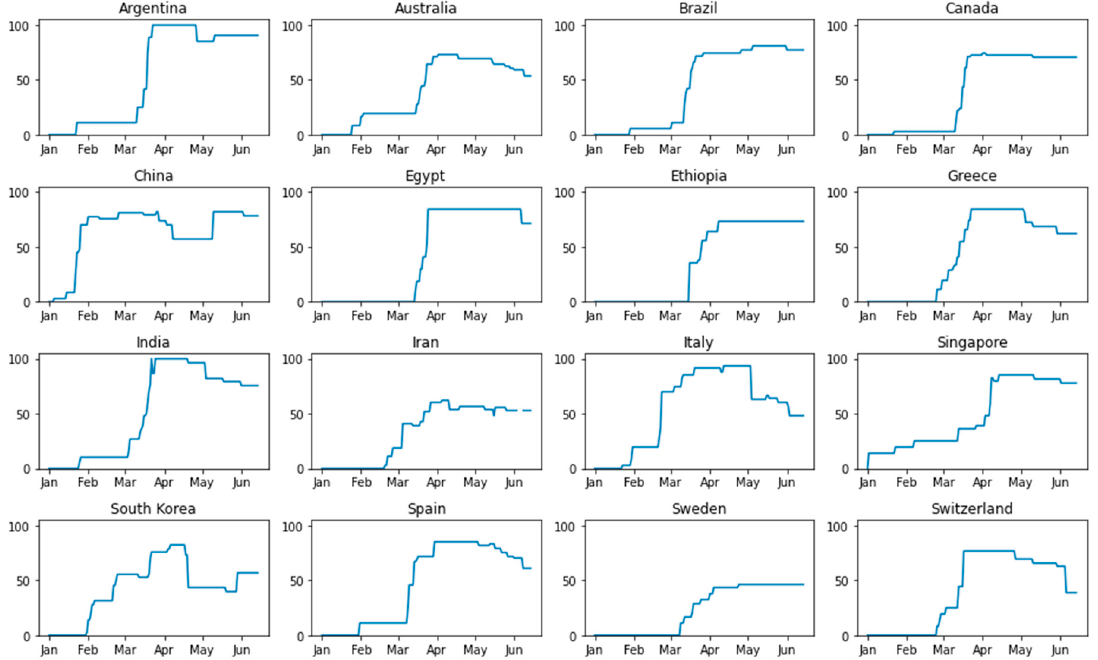
Figure 3. Intensity of government response strategies (created using the Oxford COVID-19 Government Response Tracker (OxCGRT) data ) .